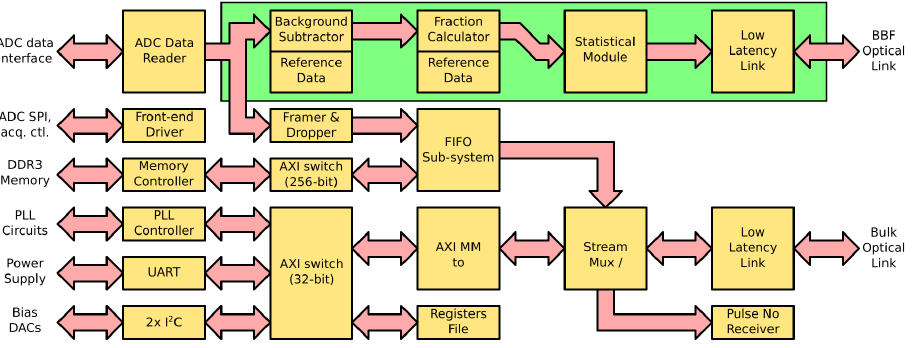
Figure 8. A block diagram of DAM FPGA